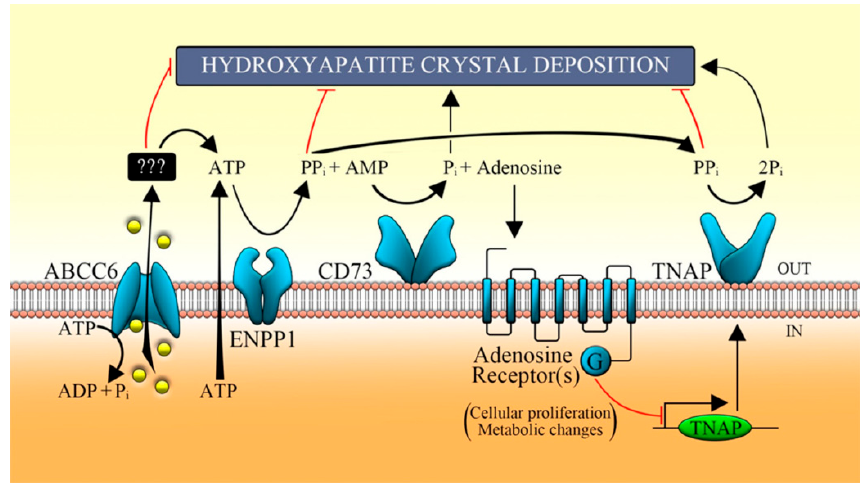
Figure 4. Proposed pathomechanism of PXE. ABCC6 transporter mediates the efflux of ATP, which is metabolized by some ecto-nucleotidases (such as ENPP1) in AMP, which in turn is converted in adenosine and Pi by CD73. In the extracellular milieu, nucleotides regulate the activity of TNAP through the purinergic pathway and prevent the ectopic mineralization [32]. ABCC6, ATP-binding cassette, sub-family C, member 6; ENPP1, ecto-nucleotide pyrophosphatase/phosphodiesterase type I; CD73, cluster of differentiation 73; TNAP, tissue non-specific alkaline phosphatase; Pi, inorganic phosphate; PPi, inorganic pyrophosphate [35].